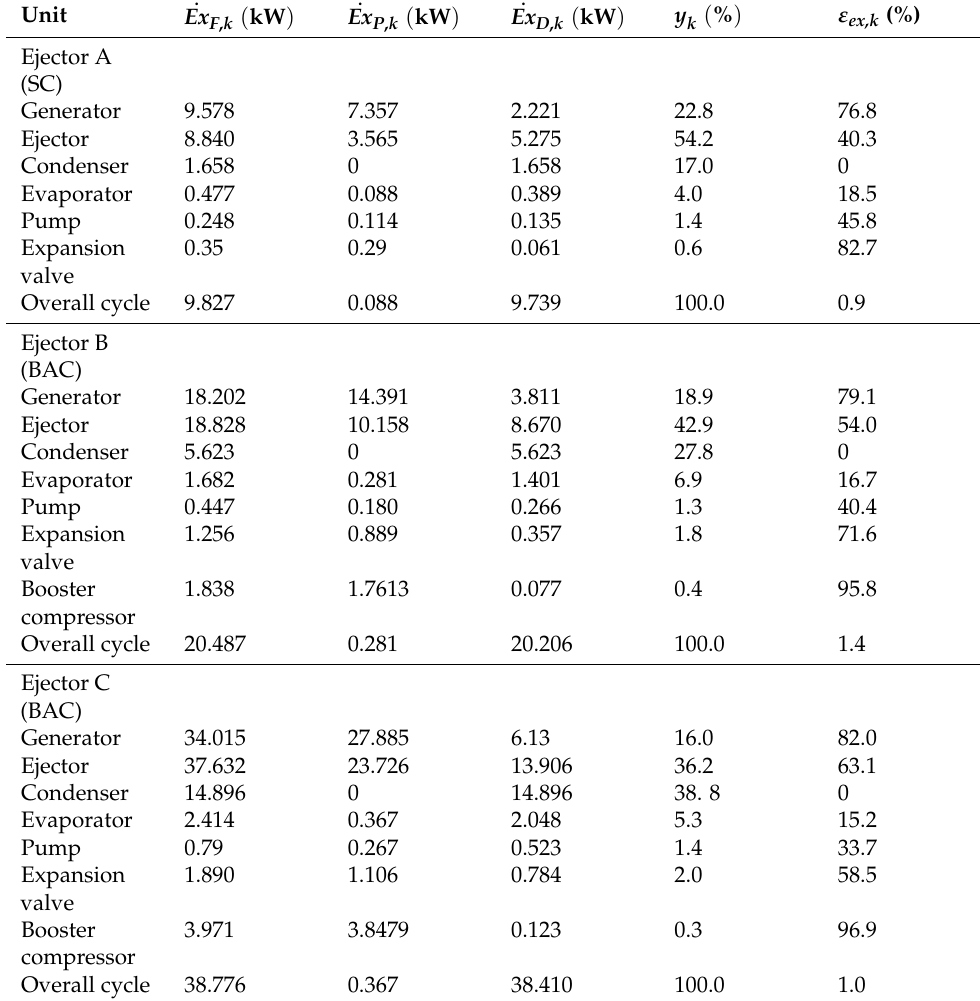
Table 6. Exergy rates of the fuel, product, destroyed exergy, exergy loss, and exergy efficiency for the simple Ejector A refrigeration sub-cycle and compression-assisted Ejector B and C sub-cycles at nominal conditions, with R245fa as the working